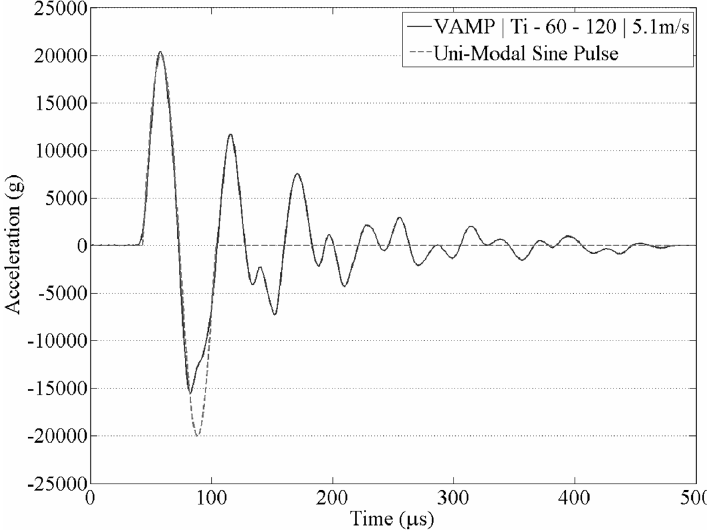
Fig. 10. Input acceleration data for each signal analysis